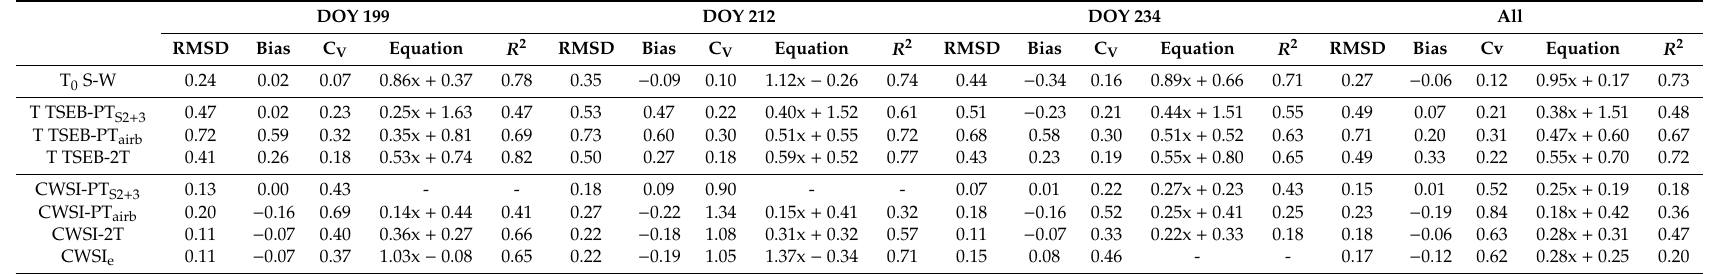
Table 2. Accuracy statistics for regressions between modelled transpiration, obtained from the vine water consumption model, and estimates of potential and actual transpiration. The latter were respectively estimated using: the Shuttleworth and Wallace model (T 0 S–W); two-source energy balance (TSEB) with (i) Priestley–Taylor with sharpened LST from Sentinel-2 and Sentinel-3 (T TSEB-PT S2 + 3 ), (ii) PT with LST obtained from very high-resolution airborne thermal imagery resampled at 20 m (T TSEB-PT airb ) and (iii) the separation of canopy ( T c ) and soil ( T s ) temperatures obtained from very high-resolution airborne thermal imagery (T TSEB-2T), and correlations with the crop water stress index (CWSI), calculated as 1-T / T 0 . CWSI e represents the CWSI obtained with the empirical baseline approach for cv.Tempranillo , using the following equations: y = − 1.780 x + 1.253 and y = 0.466 x + 5.317 (Bellvert et al. 2015), to establish the lower and upper limits. Root mean square deviation (RMSD) and bias (modelled without the estimated values) are expressed in mm day − 1 ; the coe ffi cient of variation (C V —RMSE divided by the mean of the modelled values), equation (estimated = a modelled + b) and coe ffi cient of determination ( R 2 ) are unitless. Only statistically significant regressions between the remote sensing results and water consumption model are